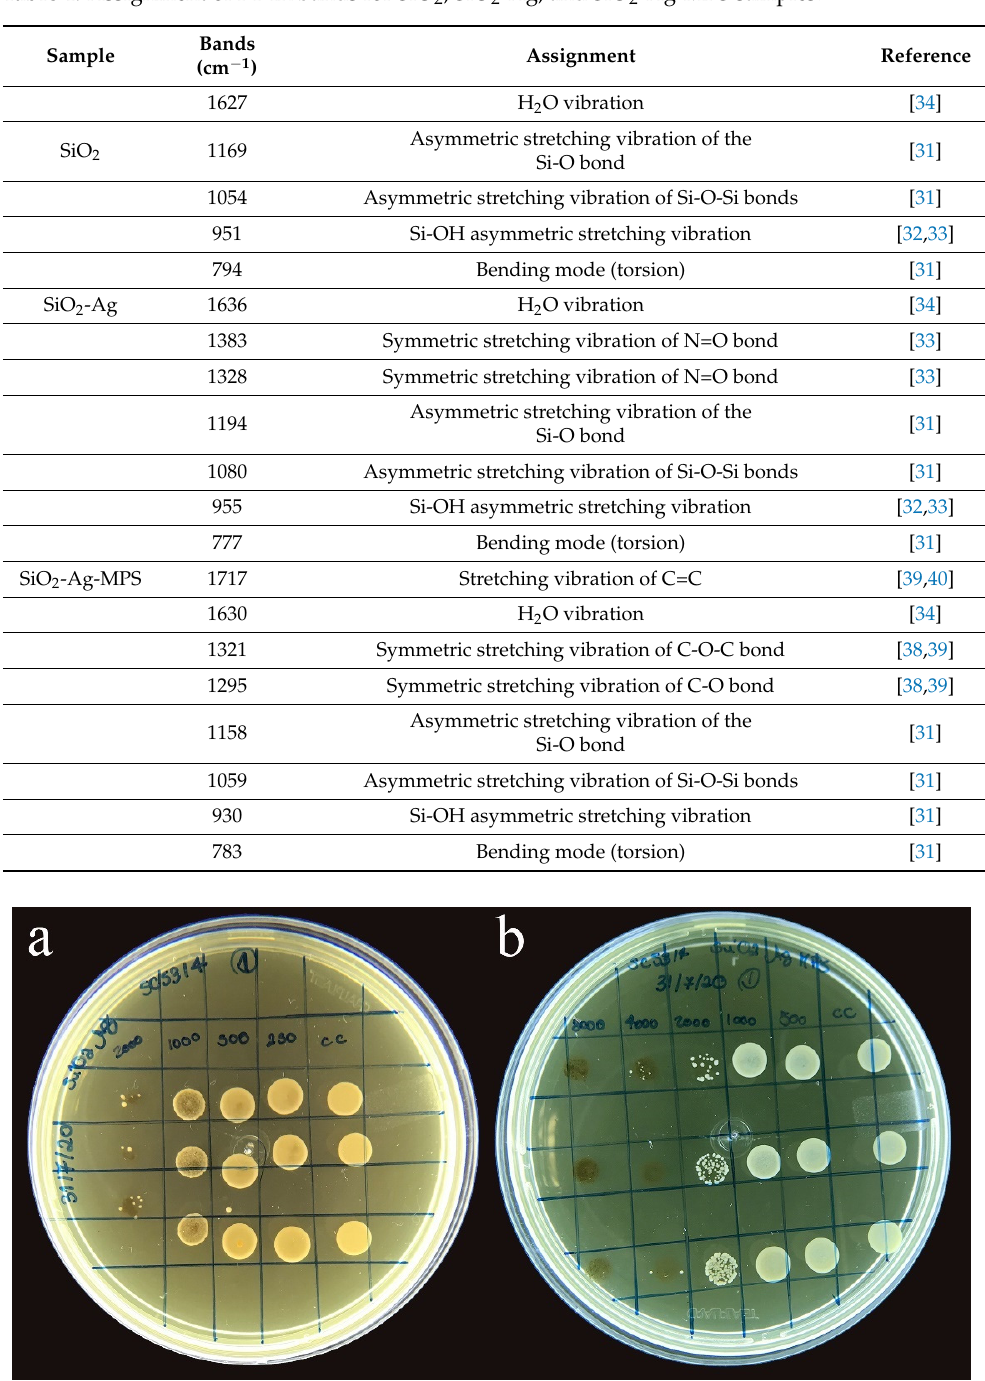
Figure 6. Images obtained by SEM-EDX of the surface of the nanocomposites of the experimental groups relative to the glaze: ( a ) group CG, ( b ) group G1, and ( c ) group G2. Figure 7. Images obtained by SEM-EDX of the surface of the nanocomposites of the experimental groups relative to the reliner: ( a ) CR group, ( b ) R1 group, and ( c ) R2 group.